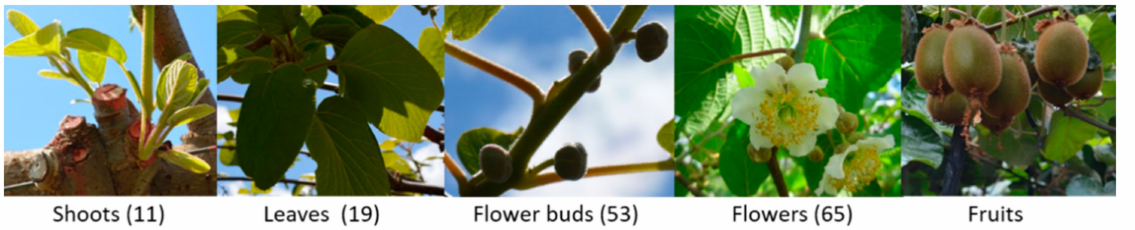
Figure 1. Tissues assayed in kiwifruit cv ‘Hayward’ including shoots leaves unfolded (11), leaves completely developed (19), flower buds growing (53), full flowering (65), fruits as the following days after full bloom (DAFB): 7, 50, 120 and 160 days. Between parenthesis are indicted the phenological stage References